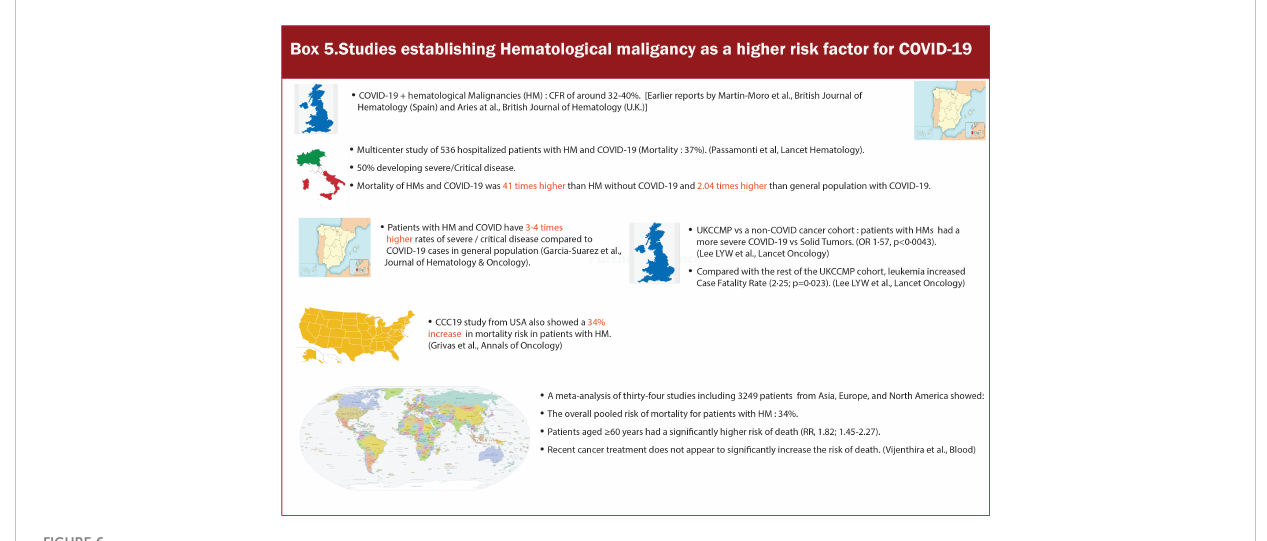
FIGURE 6 Box-5 Studies establishing hematological malignancy as a higher risk factor for